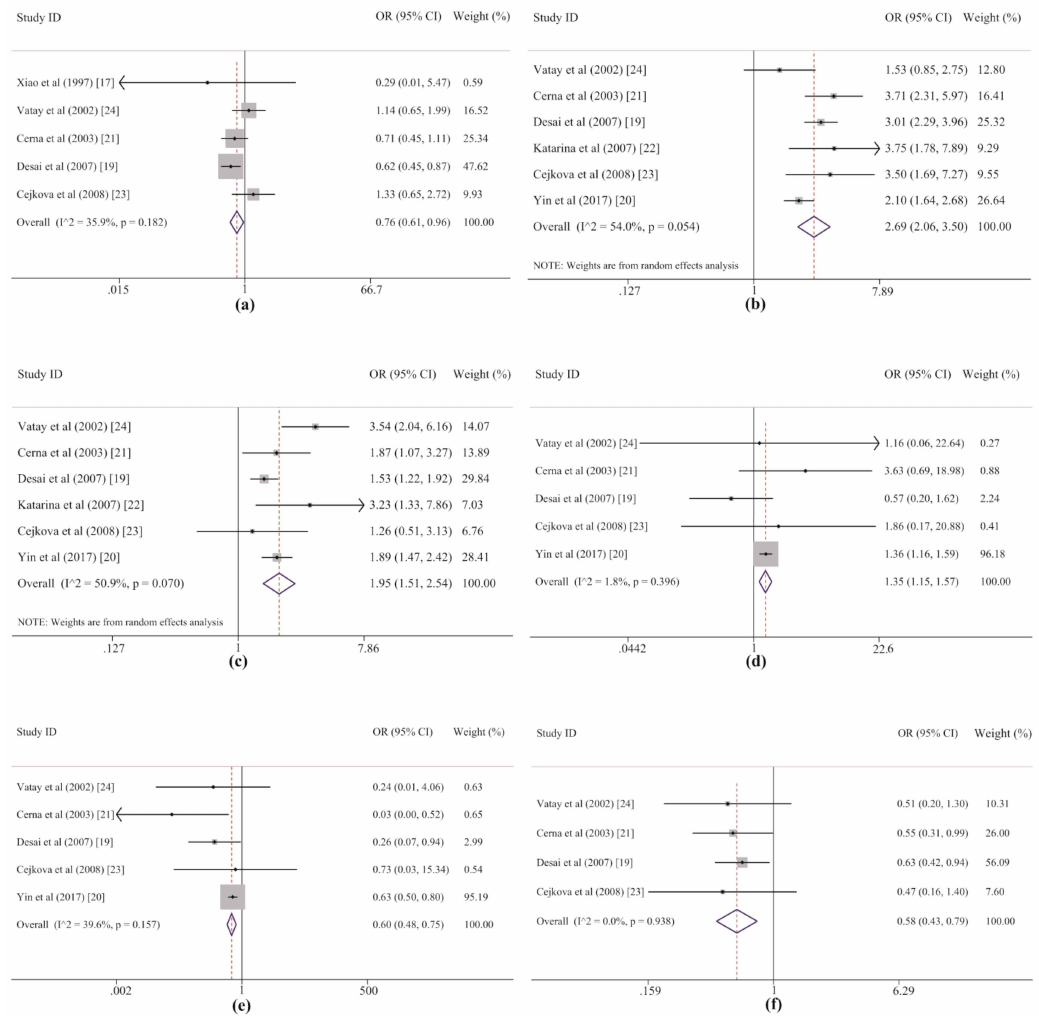
Figure 4. Forest plots of the associations between the HLA-DQB1*05 , HLA-DRB1*03 , HLA-DRB1*04 , HLA-DRB1*09 , HLA-DRB1*12 , and HLA-DRB1*13 polymorphisms and the risk of LADA: ( a ) DQB1*05 ; ( b ) DRB1*03 ; ( c ) DRB1*04 ; ( d ) DRB1*09 ; ( e ) DRB1*12 ; ( f ) DRB1*13